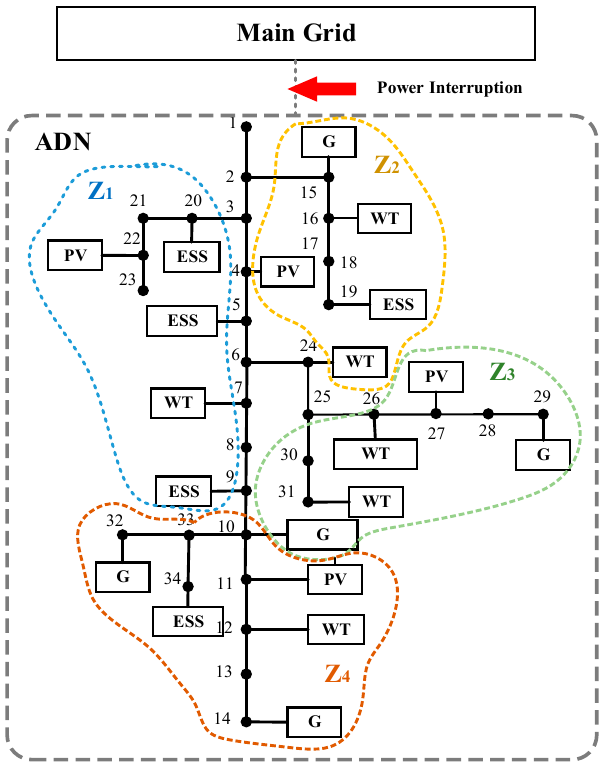
Figure 4. Structure of modified IEEE 34-node system. Table 1. The capacity parameter of distributed energy resources (DER)